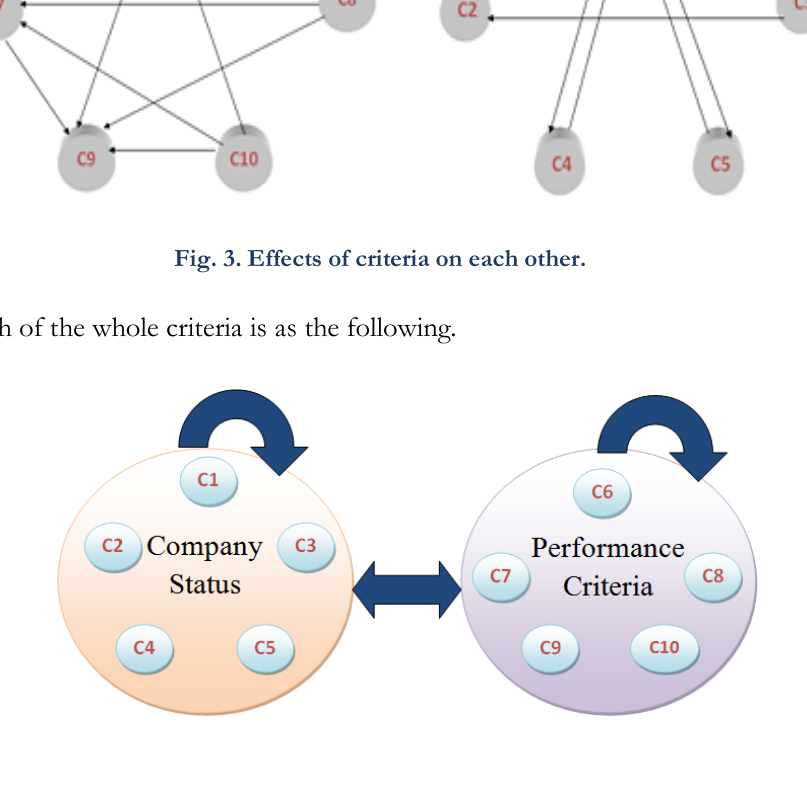
Fig. 4. Final diagraph of effects of criteria on each